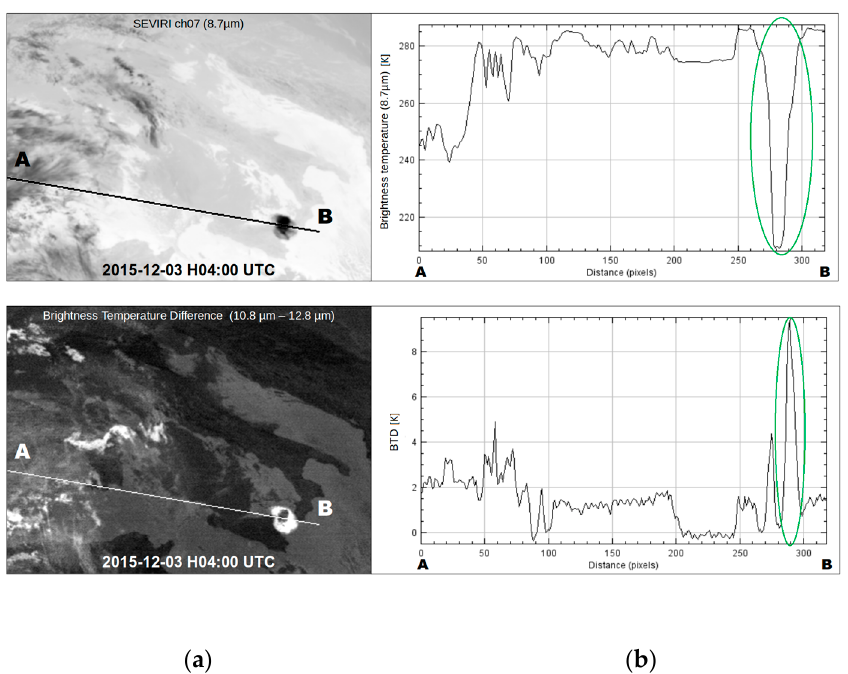
Figure 5. Spinning Enhanced Visible and Infrared Imager (SEVIRI) data of 3 December 2015 at 04:00 UTC: ( a ) Top: Brightness Temperature Difference (BTD) image; Bottom: brightness temperature in the channel 7 (at 8.7 µ m); ( b ) signal changes recorded along the A-B transect region. Green ellipse indicate the region affected by the eruption column.